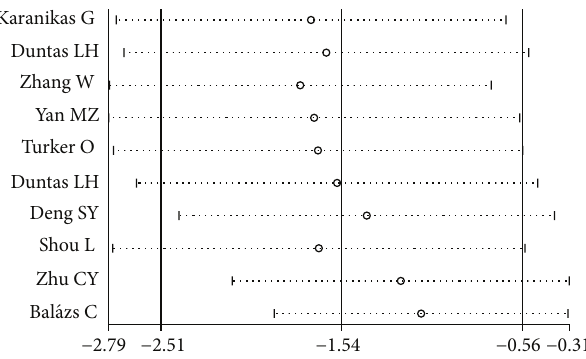
Figure 5: Sensitivity analysis: examining the influence of individual studies of ten studies (TPOAb titers and Se supplementation treatment). This figure shows the influence of each study on the meta-analysis, in which the meta-analysis estimates are computed by omitting one study at a time. By default, random-effects analyses are displayed.